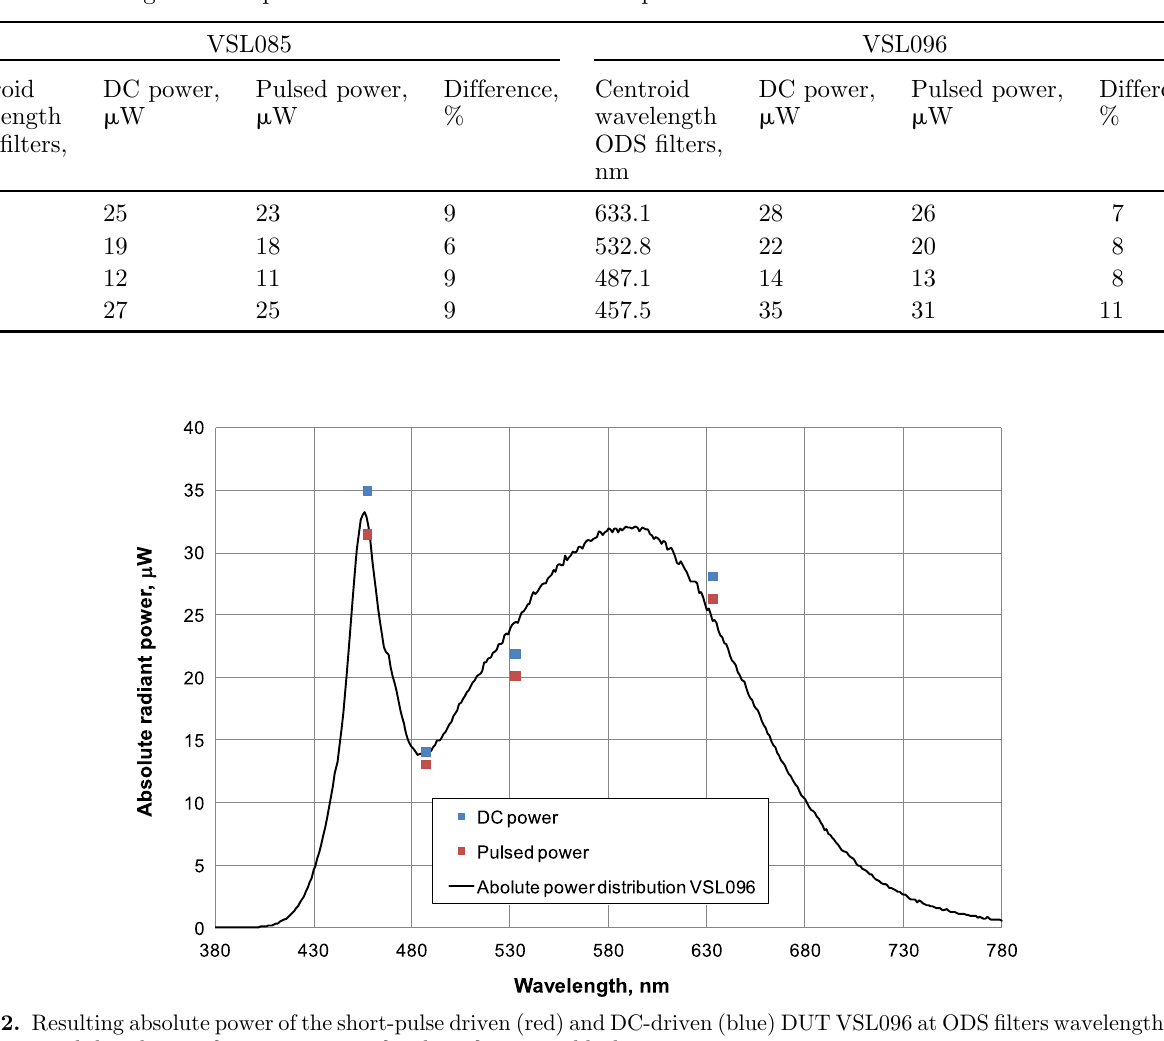
Table 7. Resulting absolute power of the DC-driven and short-pulse driven DUTs VSL085 and